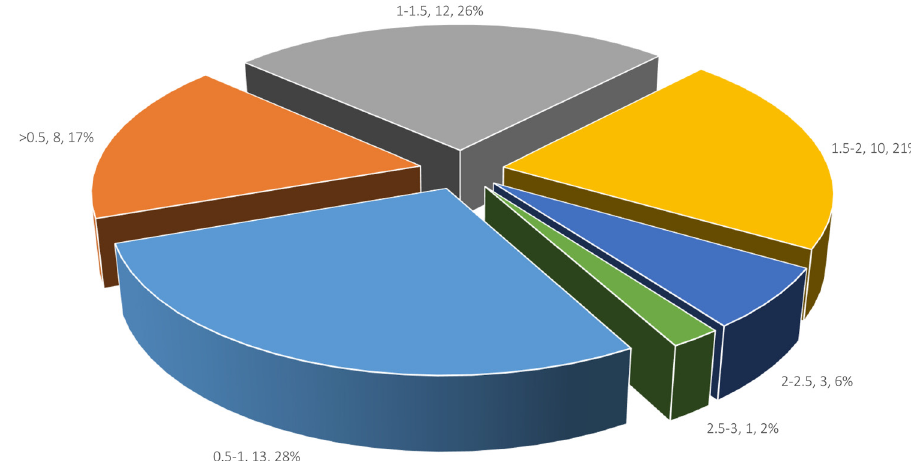
Figure 4: velocity distribution in the main pipes.